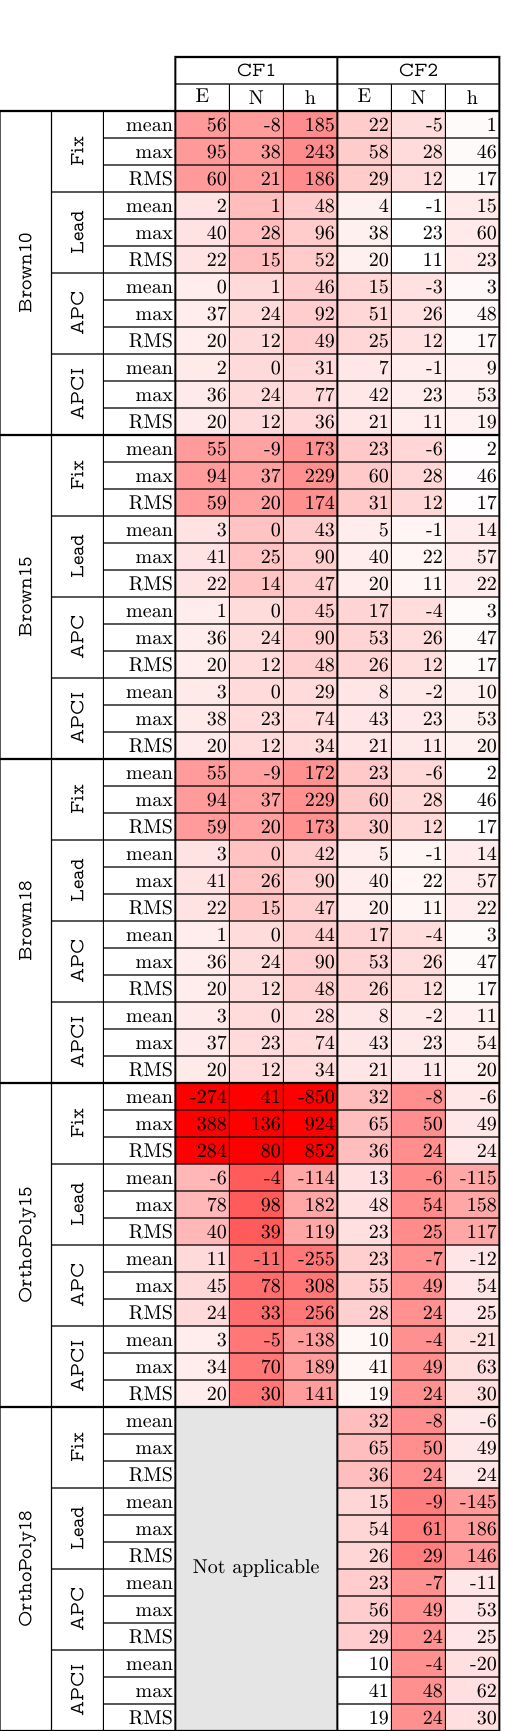
Table 2. Statistics of the checkpoints error for PF . Units are